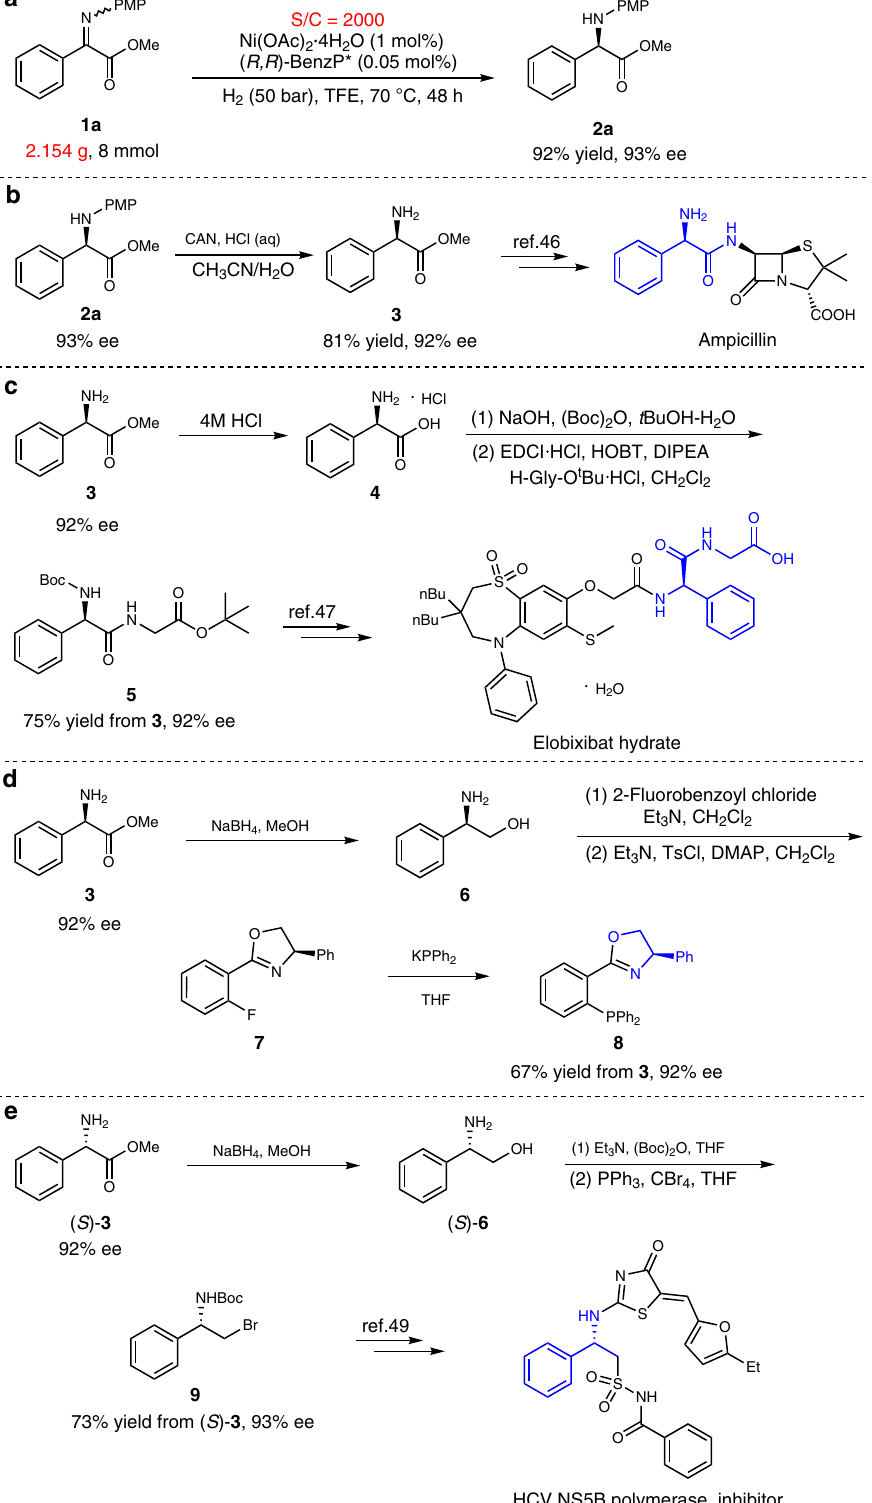
Fig. 2 Practical applications. a A gram scale experiment. b The removal of PMP. c The synthesis of elobixibat hydrate intermediate. d The synthesis of ligand 8 . e The synthesis of HCV NS5B polymerase inhibitor